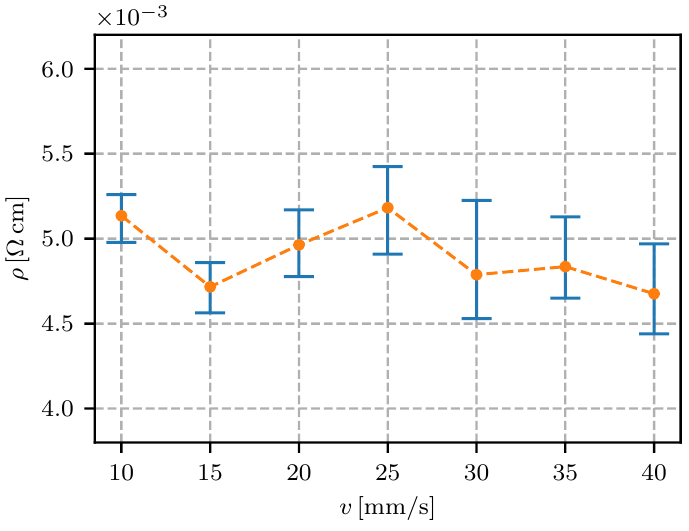
Figure 13. Resistivity for different printing speeds v